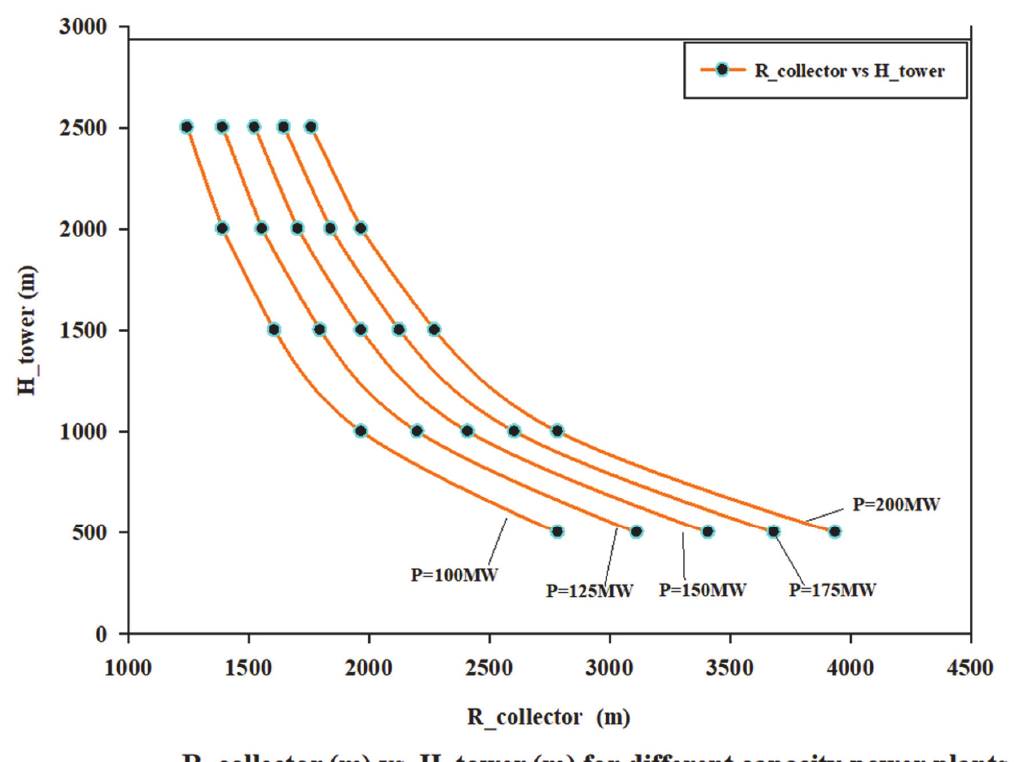
Figure 9. Effect of variation in collector radius ( R Collector ) and tower height ( H Tower ) on power output of the SUTPP.